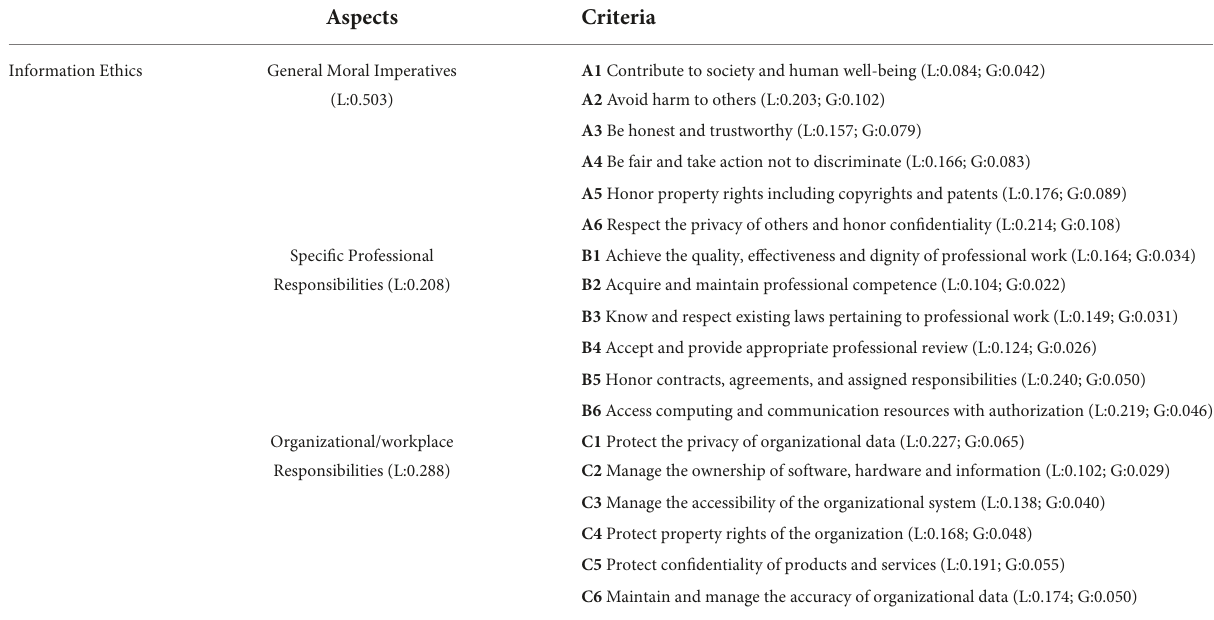
TABLE 14 Library and information science experts’ local and global weights of all criteria of the